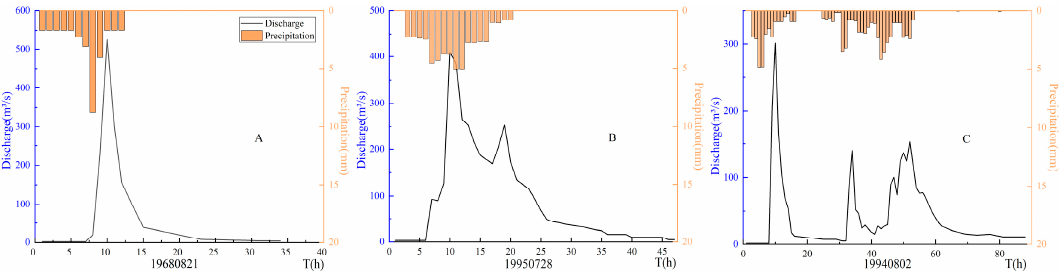
Figure 6. 19680821 ( A ), 19950728 ( B ) and 19940802 ( C ) flood process line of Gushanchuan Basin.